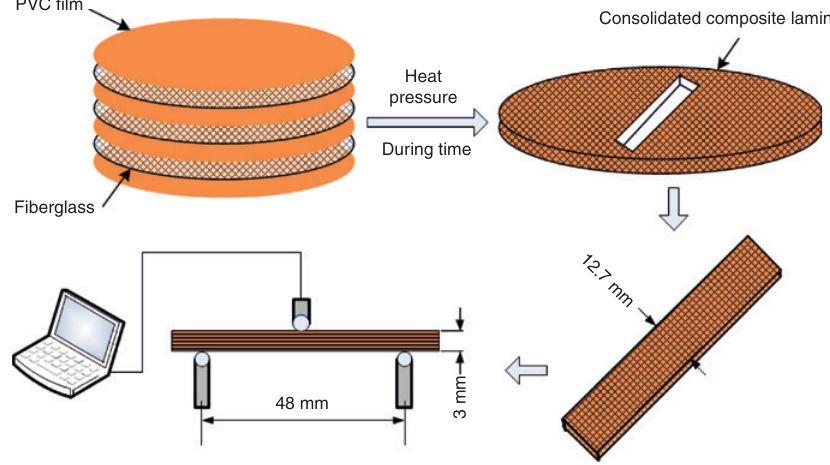
Figure 3: Schematic of the composite laminate production process and three-point bending